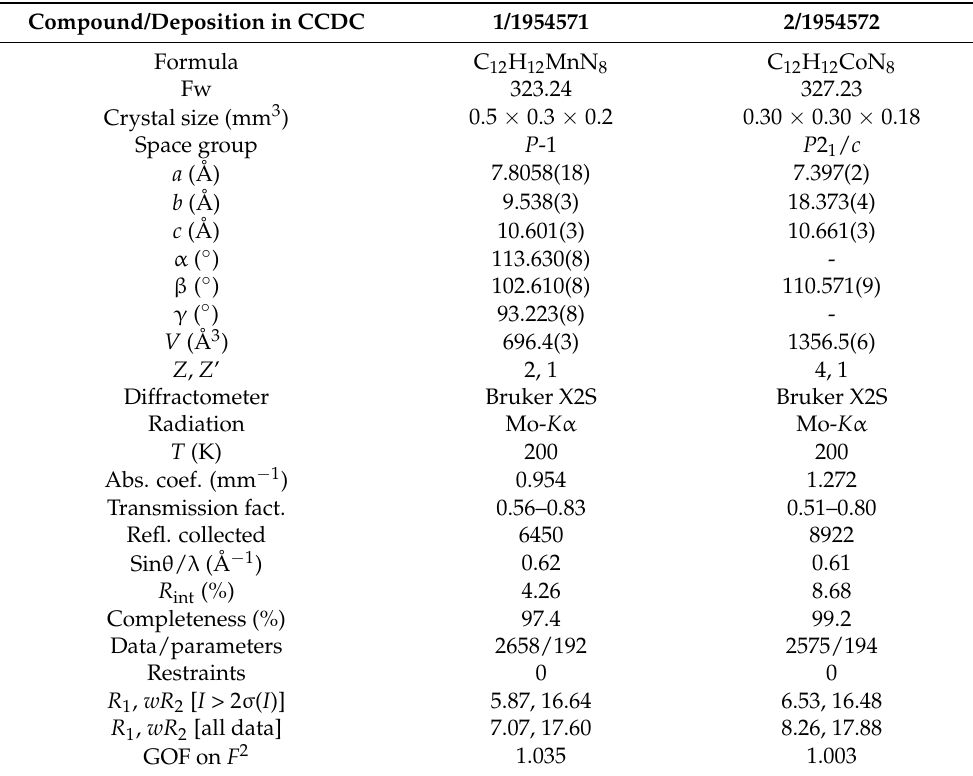
Table 2. Crystal data and refinement